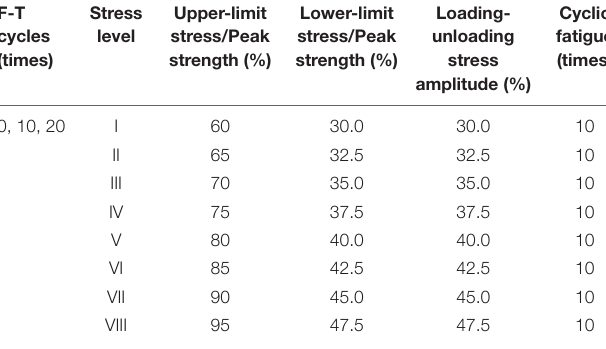
TABLE 2 | Loading-unloading cyclic test